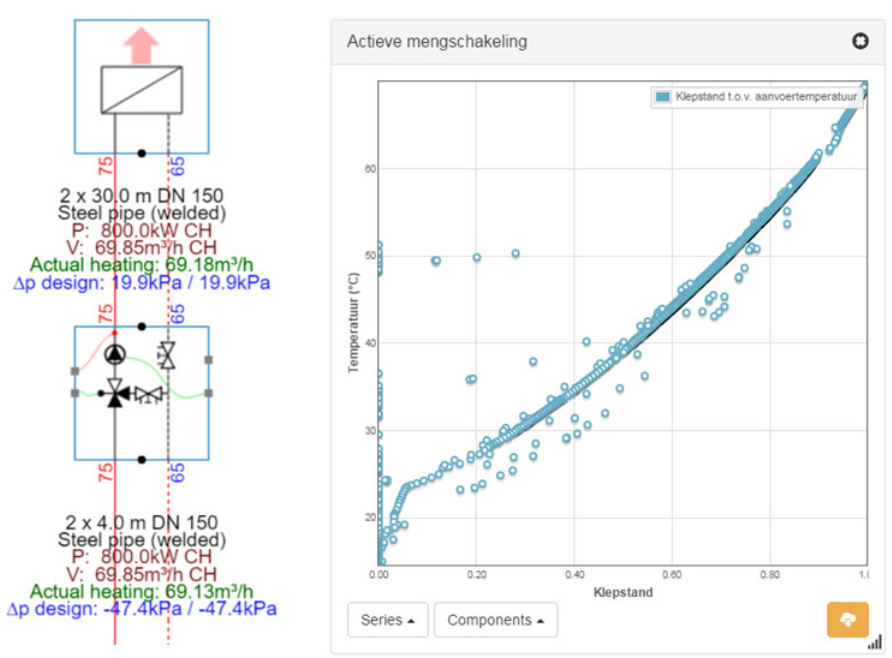
Fig. 24. – The scatter plot on the right shows the behaviour of the riser temperature according to the position of the three-way valve (power control by variable water temperature, P&ID on the